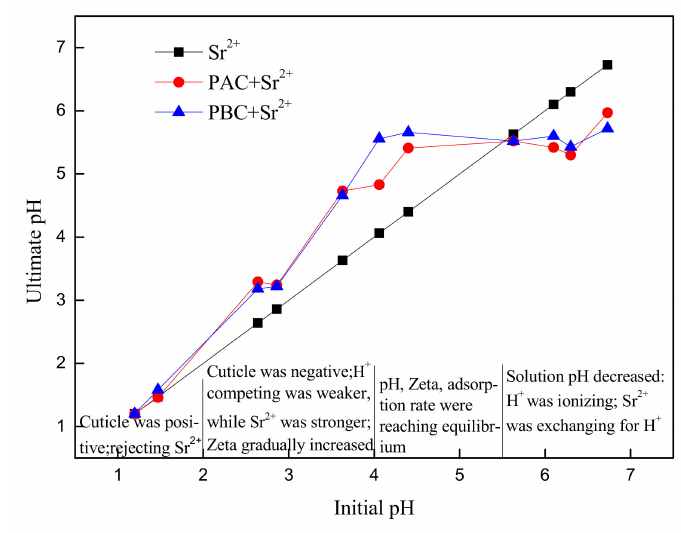
Figure 7. Solution pH before and after Sr adsorption by adaxial (PAC) and abaxial (PBC) cuticle of Photinia serrulata